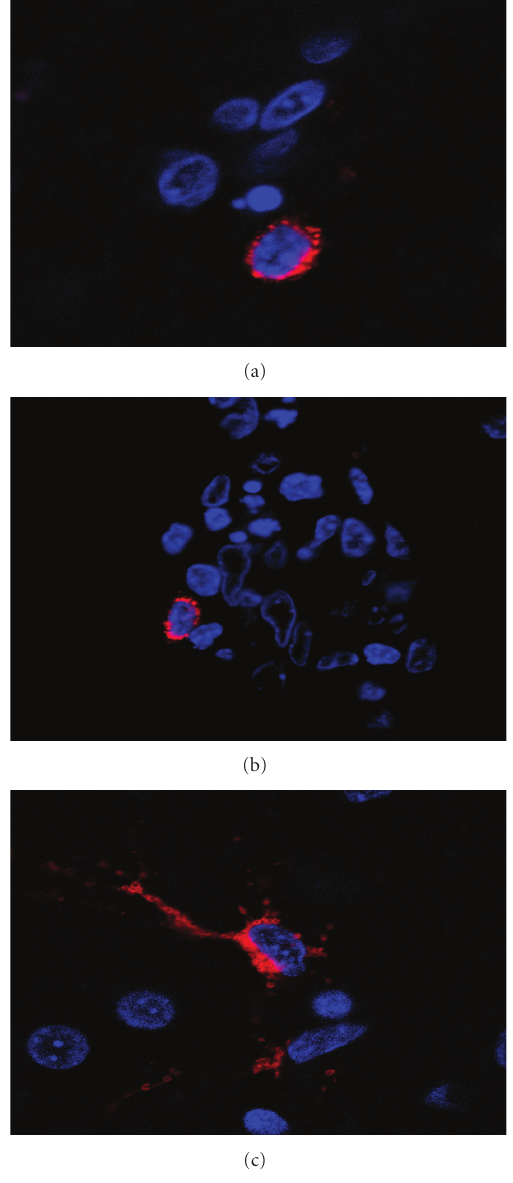
Figure 3: Confocal immunofluorescence images of brain tissues stained with MDV pp38-specific monoclonal antibody BD1. Brain tissues from birds infected with (a) wild-type C12/130, (b) pC12/130-10, and (c) pC12/130-15 viruses. The brain tissues were taken eight days postinfection showing infected cells stained with pp38- (red) and DAPI- (blue) stained